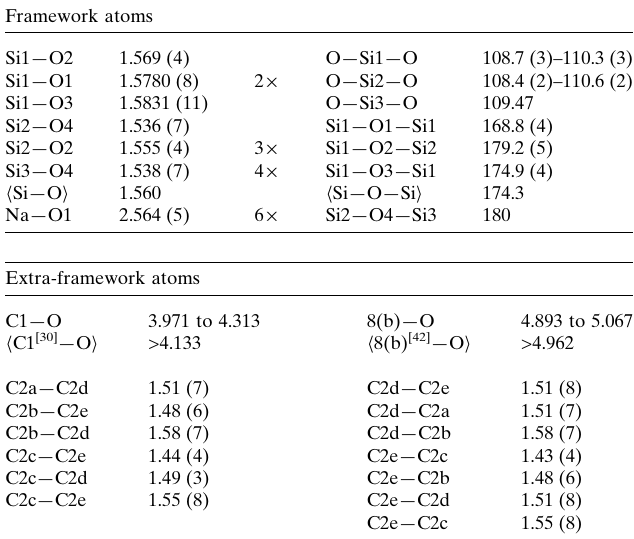
as ranges with the minimum and maximum values for the crystallographically independent 12 Si1 x O 4 , four Si2 x O 4 and the one Si3O 4 unit. The variation of the individual and average values corresponds to the range for 13 O1 x , 12 O2 x , 6 O3 x and 4 O4 x